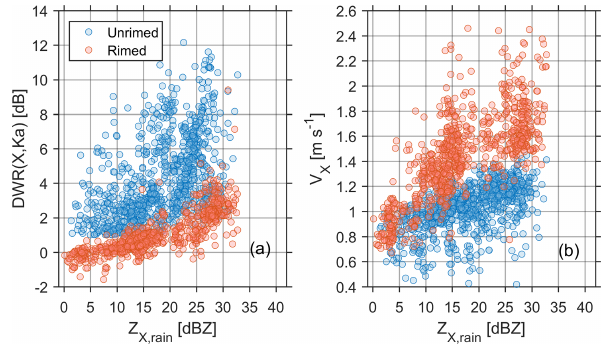
Figure 3. Distribution of (a) DWR(X, Ka) and (b) V X above the ML as a function of Z X , rain . Note that no transitional snow type between unrimed and rimed is